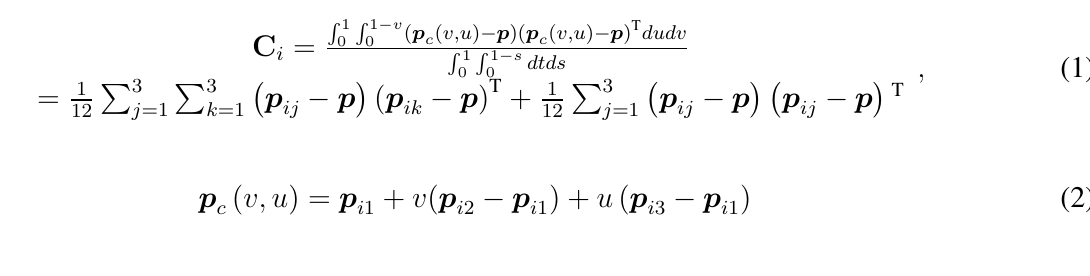
Figure 2. An illustration of the multi-scale rotational projection statistics (RoPS) feature description process (figure best seen in